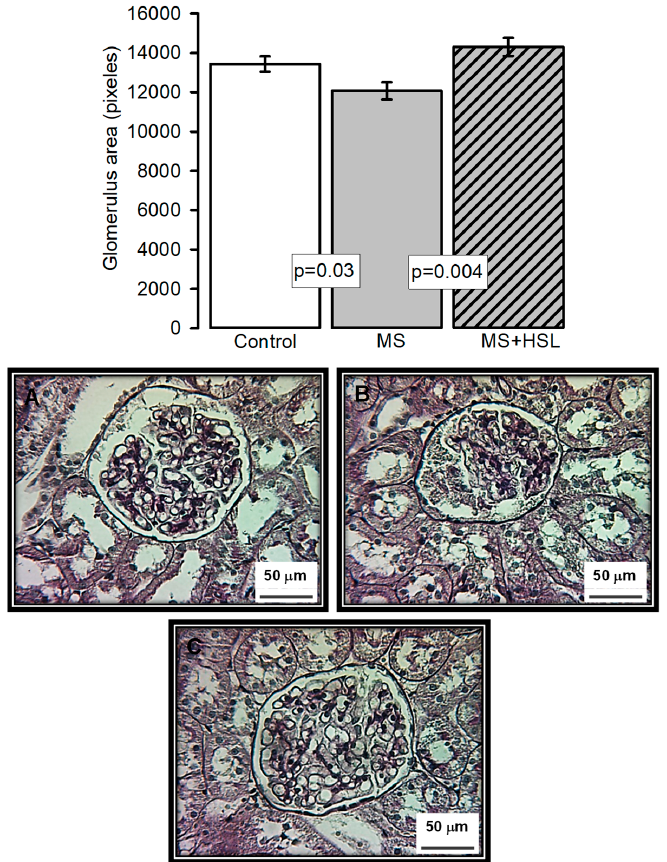
Figure 1. The top panel histogram that represents the densitometric analysis of the glomerular area in the experimental groups. Panel (A, B and C) Representative Photomicrographs of rat renal cortex. Images show the glomerulus from ( A ) control rats, ( B ) MS rats, and ( C ) MS+HSL. No abnormalities were observed under light microscopy in control and MS+HSL groups, where glomerular spaces and loops with their fine and delicate membrane are preserved. However, in the kidney of the MS rats showed retracted glomerular tuft, fibrosis, and an increased urinary space with detritus. (Periodic acid-Schiff stains, 400×).